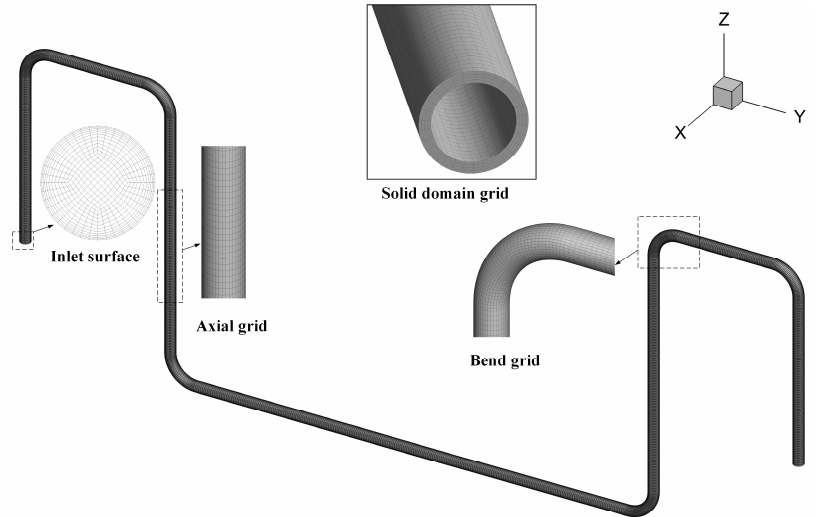
Figure 2. The computational mesh of the whole domain and the zoom-in view of key parts. A mesh independence check is performed prior to the simulations. The key calculation results obtained by five mesh systems are compared in Table 3, where P RMS and X RMS are the RMS pressure stress acting on the inner surface of associated bend and the RMS displacement of corresponding bend along the X direction, respectively. It is seen that the differences of numerical results become smaller as the number of grids increases, and both P RMS and X RMS converge at M4, as the relative difference between M4 and M5 is less than 1%. Therefore, the mesh resolution of M4 is adopted in the subsequent simulations. Table 3. Mesh independence validation for the vibrating jumper in case 1.